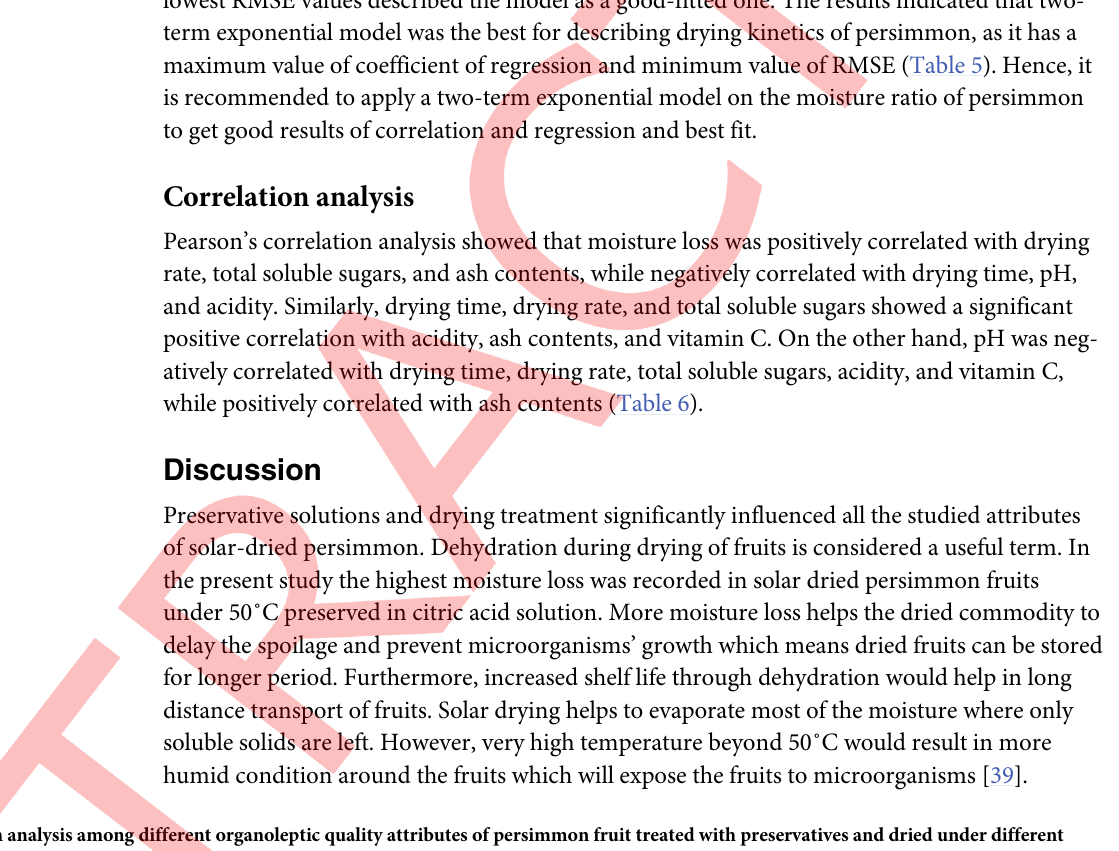
Total soluble sugars